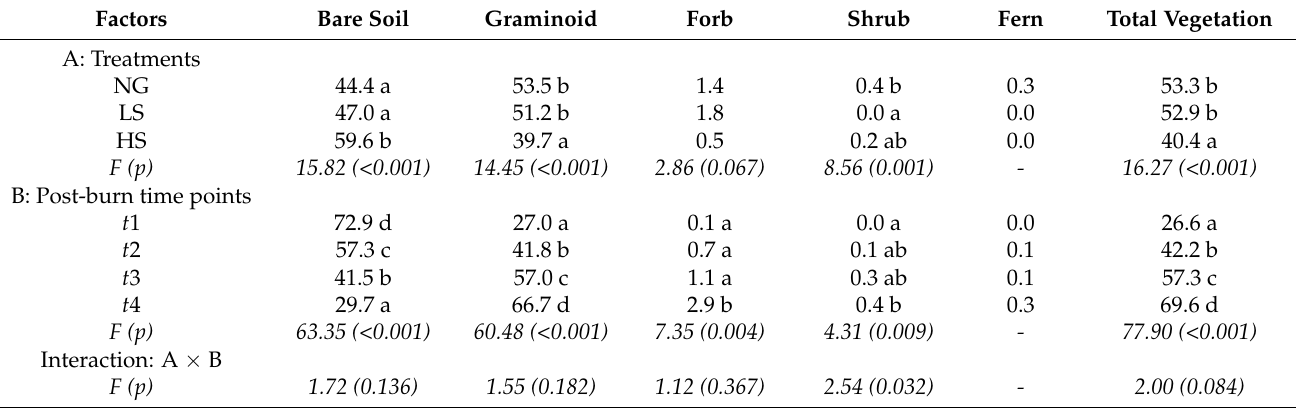
F (p) = Fisher’s test and significance between brackets. Different letters for each column show differences using Tukey test at p <